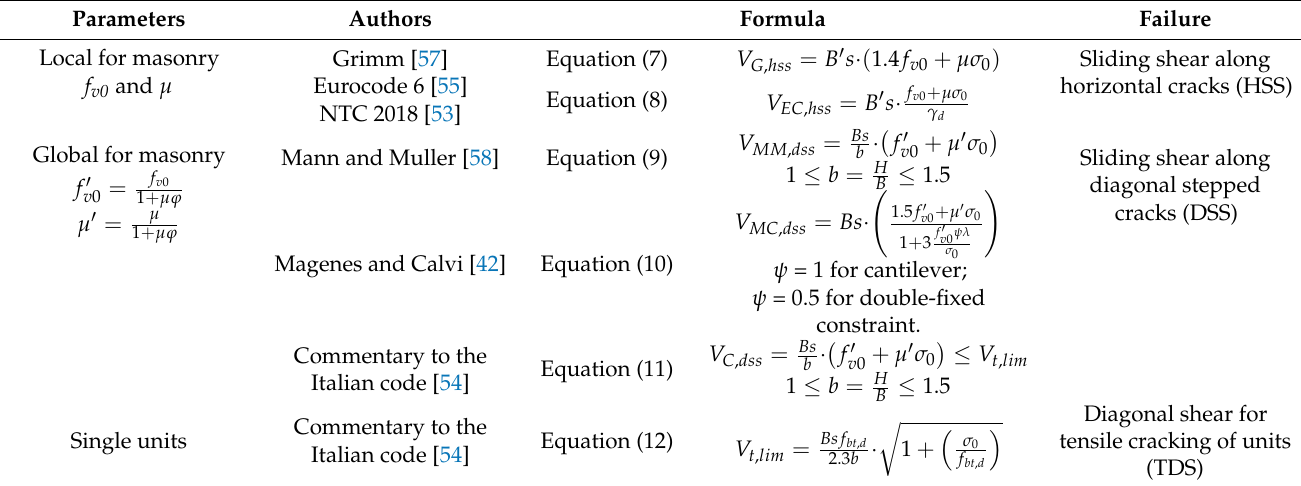
Table 2. Literature and code formulations used to predict the shear capacity of regular masonry